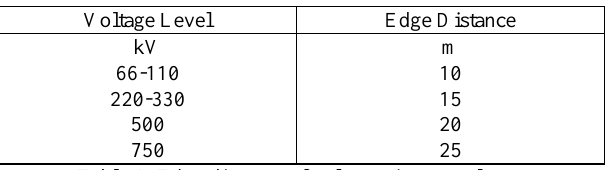
Table 2. Edge distance of voltages in general area